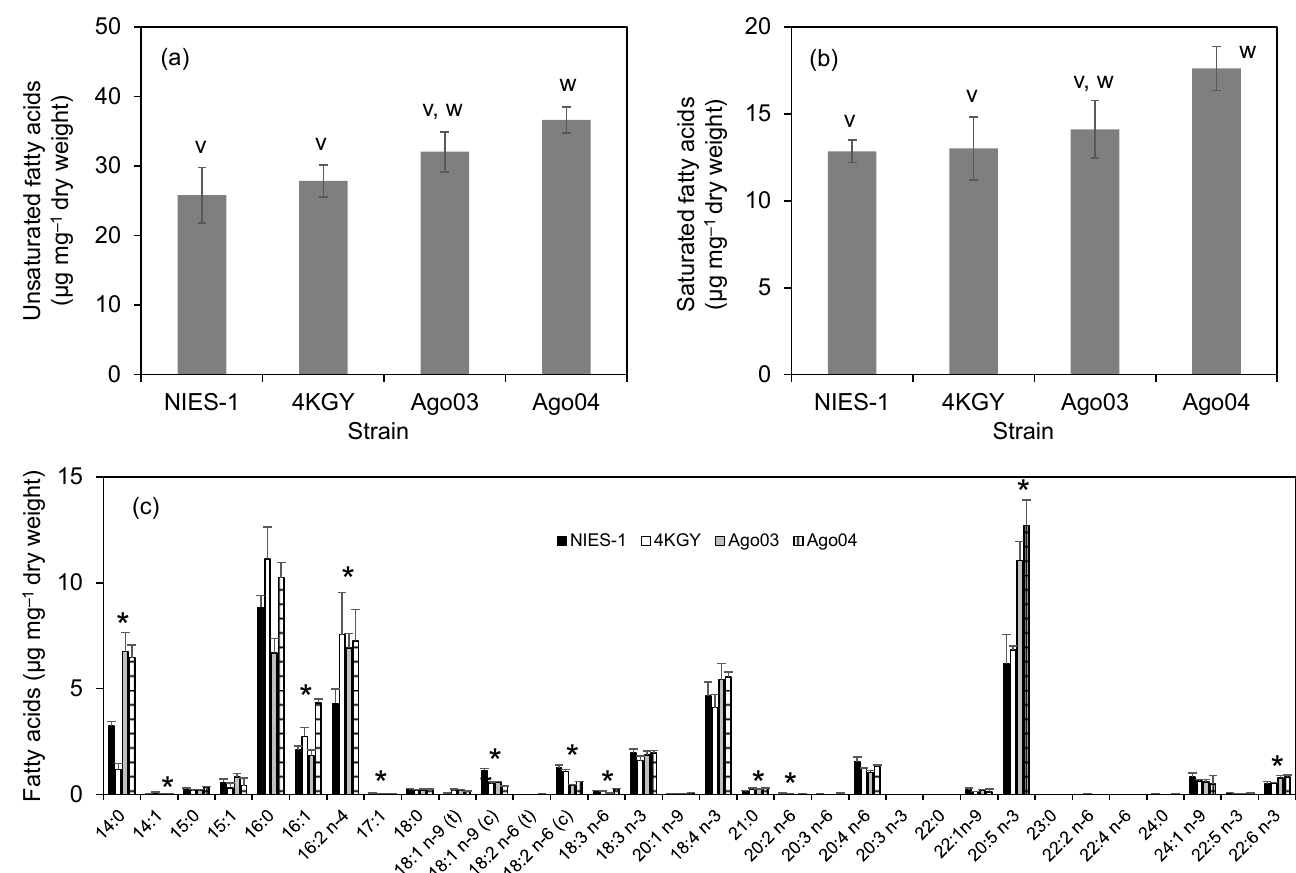
Figure 8. Content of unsaturated fatty acids ( a ) and saturated fatty acids ( b ) and their composition ( c ) in two highly toxic (NIES-1, Ago03) and two low-toxicity strains (4KGY, Ago04) of Chattonella . Each bar represents the mean ± SD of triplicate measurements. Means that are not significantly different are labeled with the same letter (v or w; p < 0.05). Fatty acids in ( c ) labeled with an asterisk had significantly different contents among the strains.